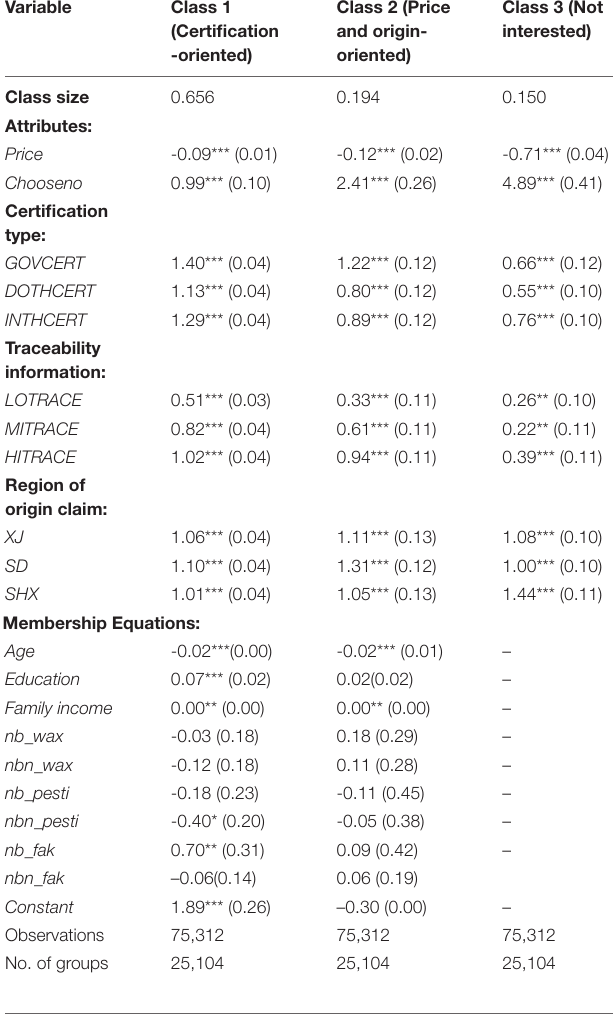
TABLE 4 | Estimates from latent class model (LC